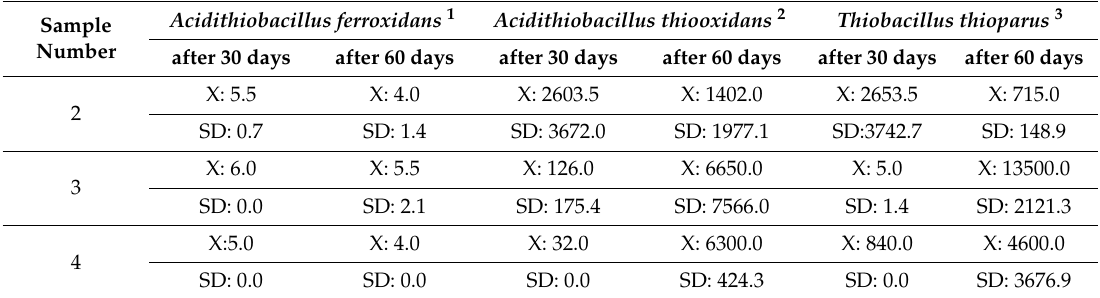
Table 7. ATP (RLU / sample) content in media with sulfur concrete after incubation with bacteria.